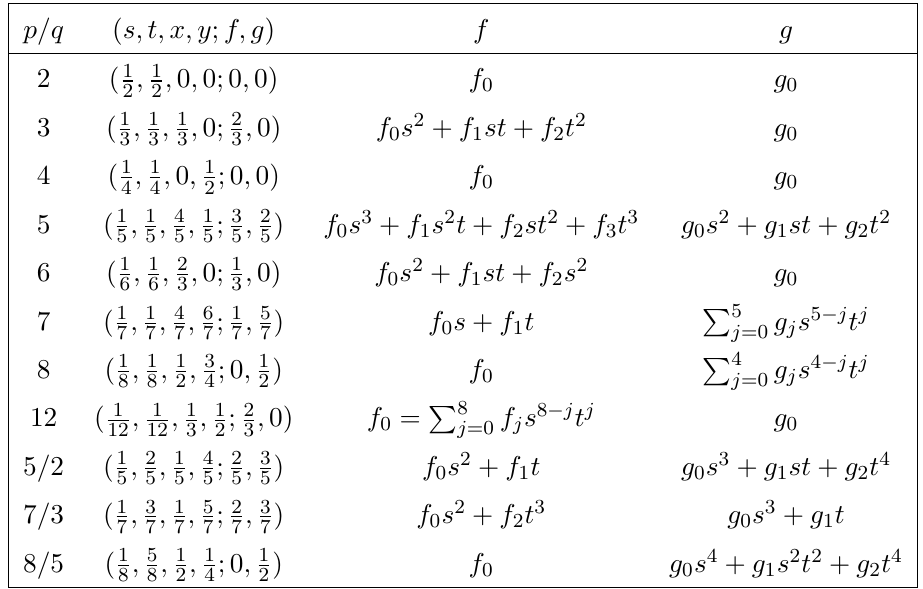
Table 1 . Weierstrass coe(cid:14)cients. All f j and g j are (cid:0)